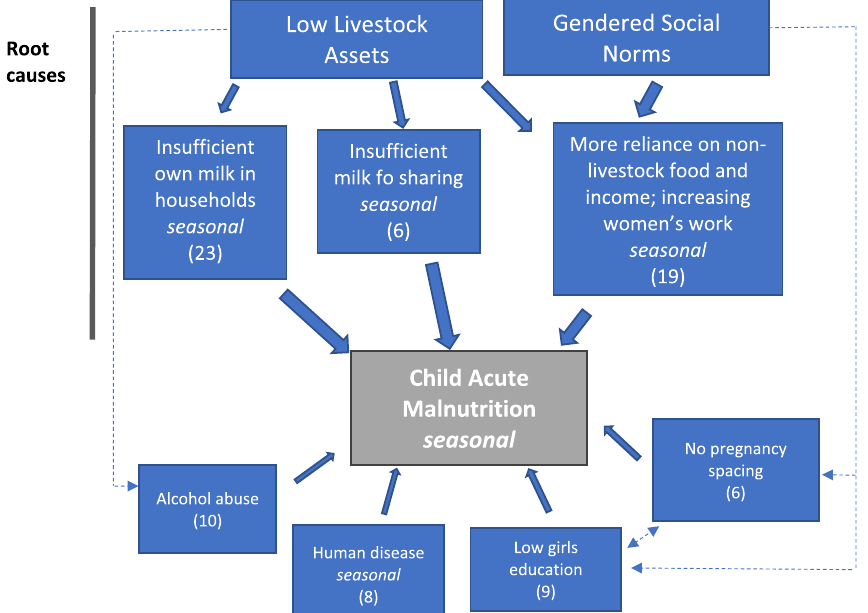
Fig. 6 Participatory causal diagram for child acute malnutrition, Karamoja. Note : The figure derived from causal diagrams produced by 16 independent groups of women participants. Figures in parentheses are median scores. Causes that showed marked seasonal variation are annotated as ‘seasonal’. There was strong agreement between the participant groups on their scoring of the causes; W